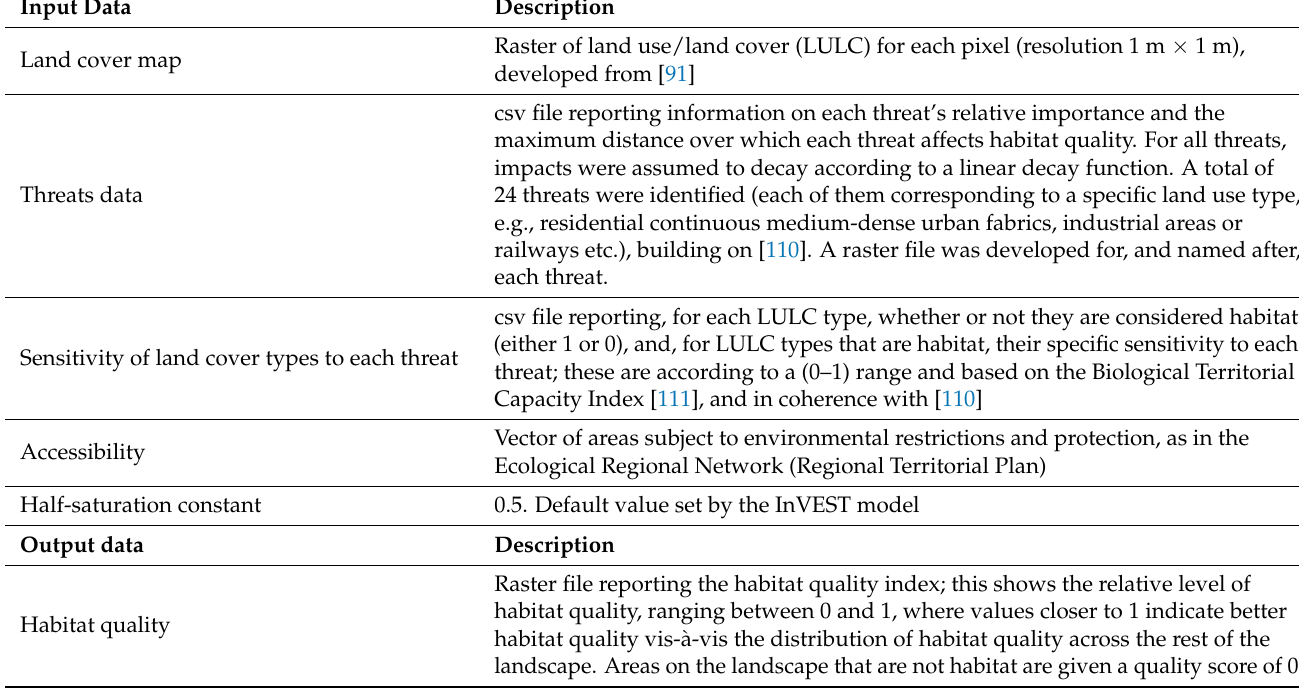
Table 8. Input and output data for the assessment and evaluation of biodiversity and habitat quality.